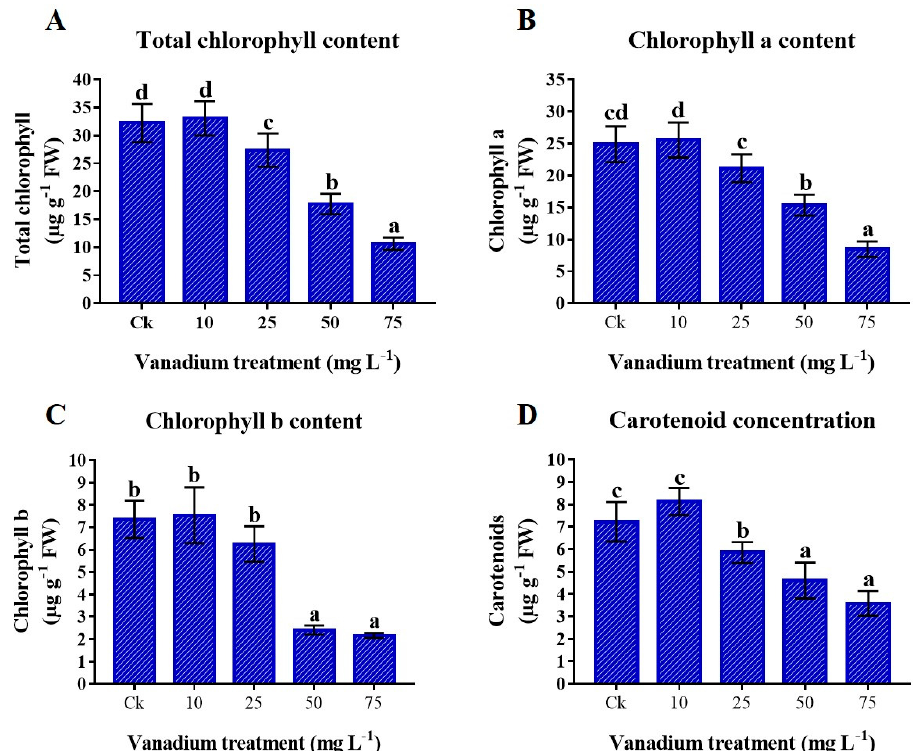
Figure 4. Influence of various V treatments on the photosynthetic pigments in the leaves of sweet potato. ( A ) Total chlorophyll content (T. Chl), ( B ) chlorophyll a (chl a), ( C ) chlorophyll b (chl b), and ( D ) carotenoid (Car) content. Duncan’s test indicates a significant difference ( p < 0.05) between the means of the five treatments indicated by different alphabets.